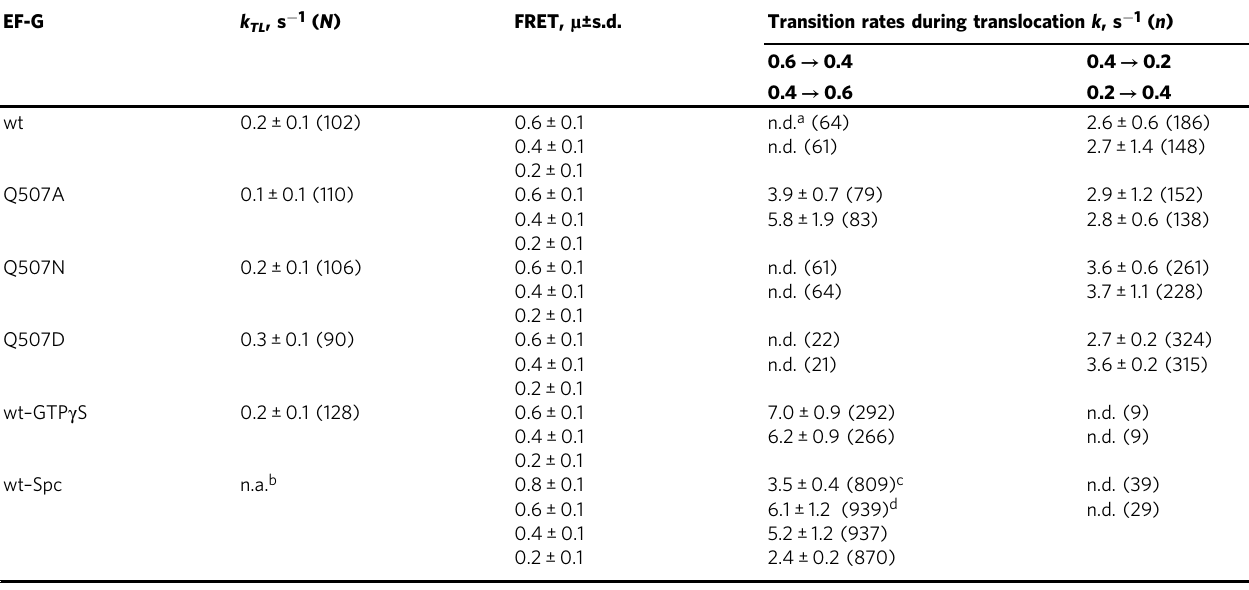
Table 1 Kinetics of pept-tRNA Lys fl uctuations during translocation on slippery mRNA. EF-G k TL , s − 1 ( N ) FRET, µ